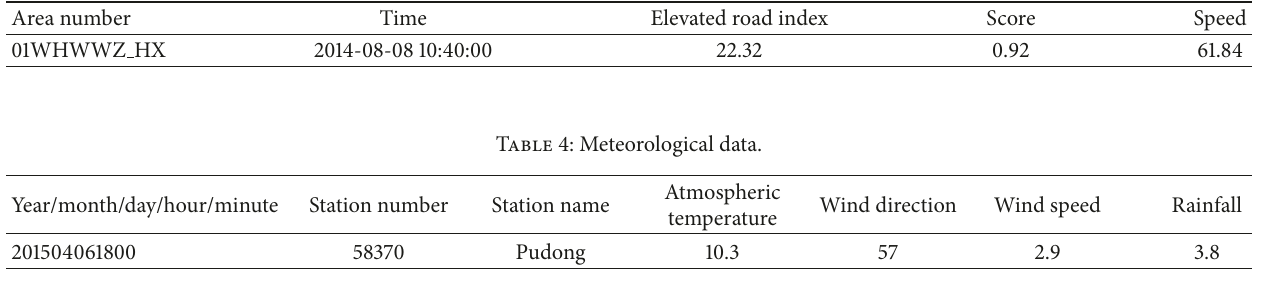
Table 2: ground index data; the elevated road index is taken from Table 3: elevated road data; the number of